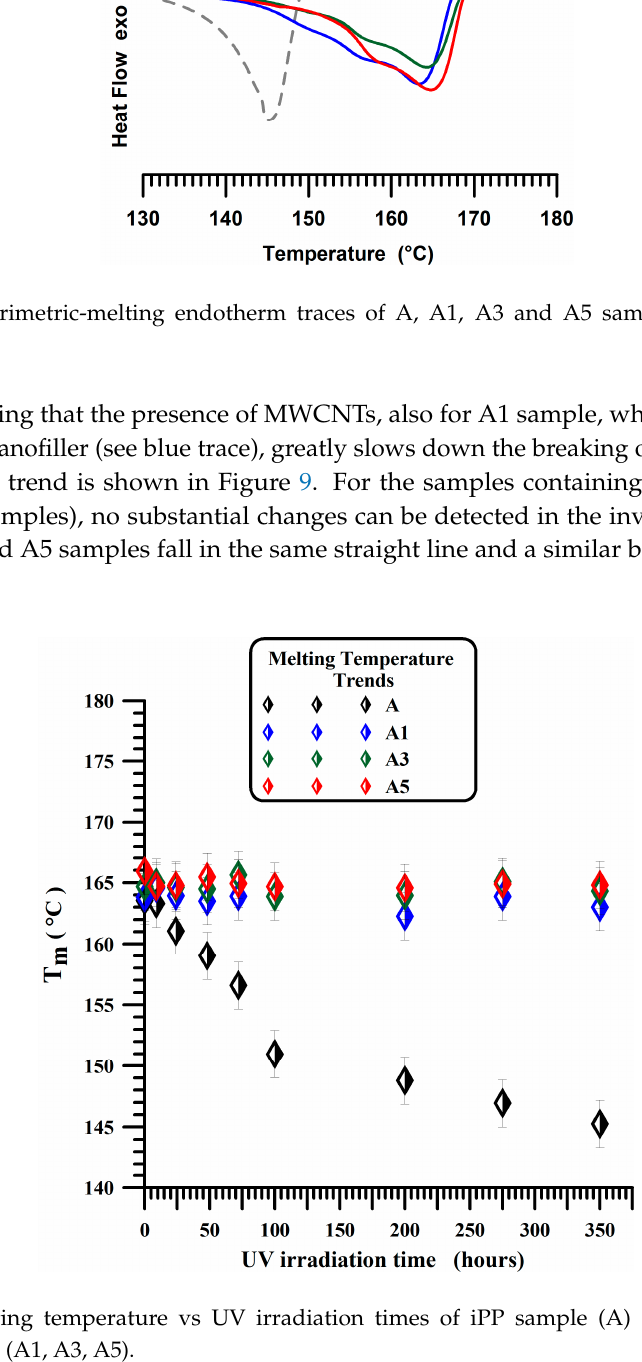
Figure 9. Melting temperature vs UV irradiation times of iPP sample (A) and photooxidated nanocomposites (A1, A3, A5). nanocomposites (A1, A3,